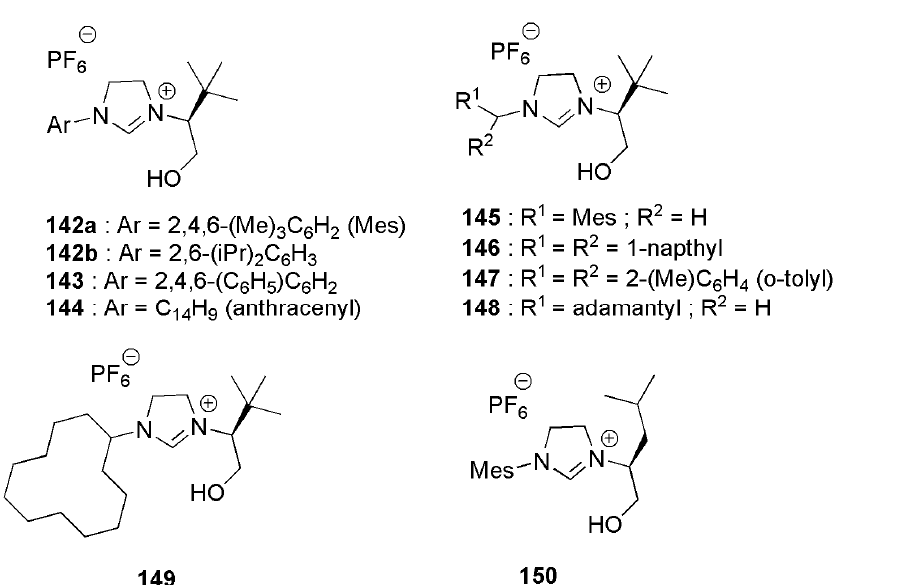
Figure 16. Proligands introduced for allylic alkylation of allylphosphates [164].